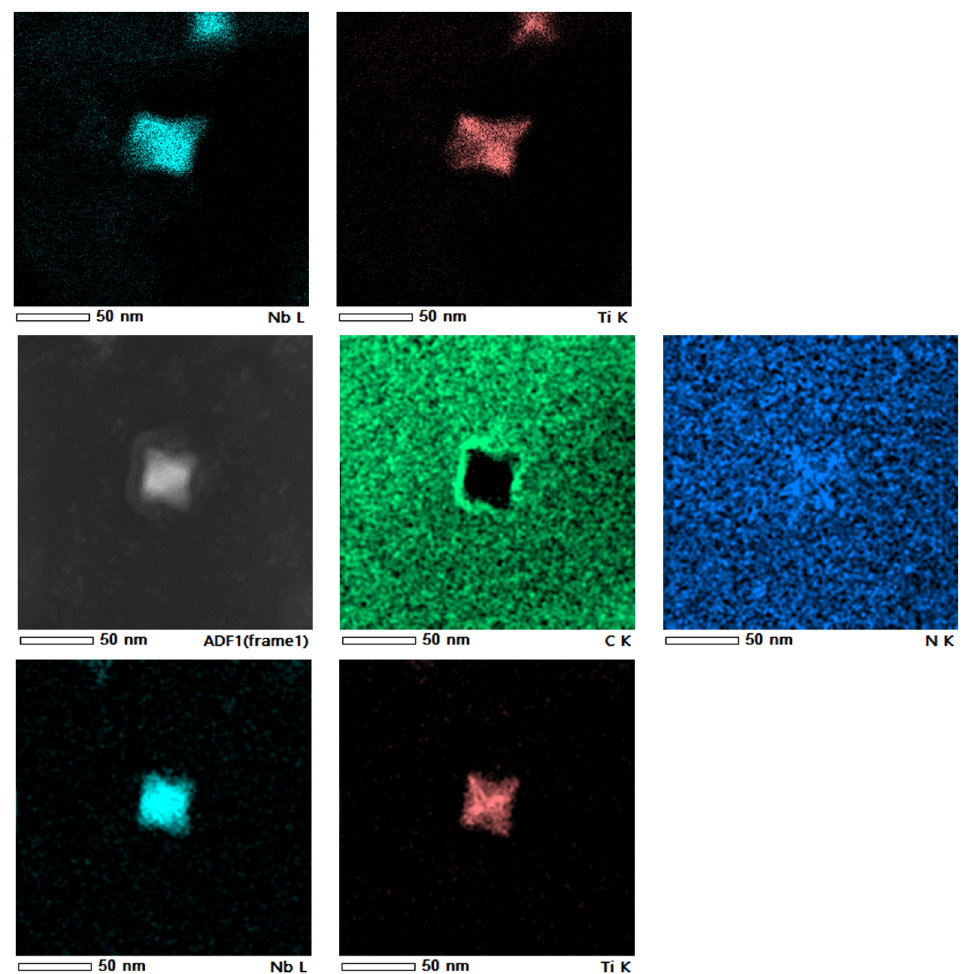
Figure 12. Composition of precipitates of different sizes and shapes.